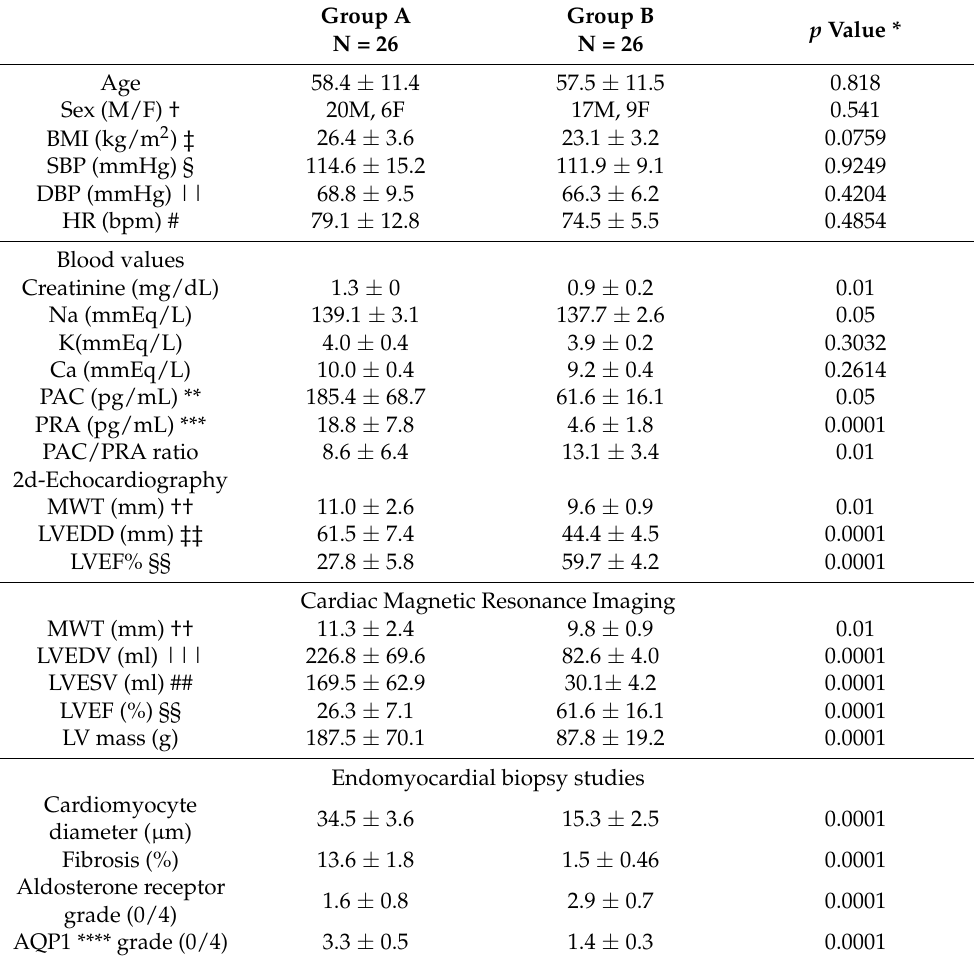
Table 1. Comparison of baseline biochemical, clinical, and endomyocardial biopsy data among patients with human heart failure (Group A) and normal controls (Group